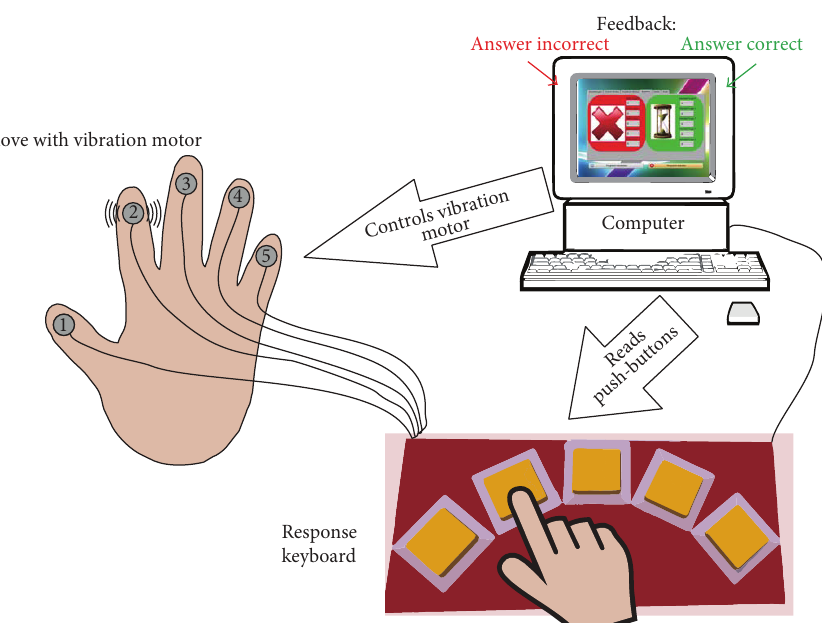
Figure 1: Schematic representation of the feedback game. The computer controls the vibration motors and reads the